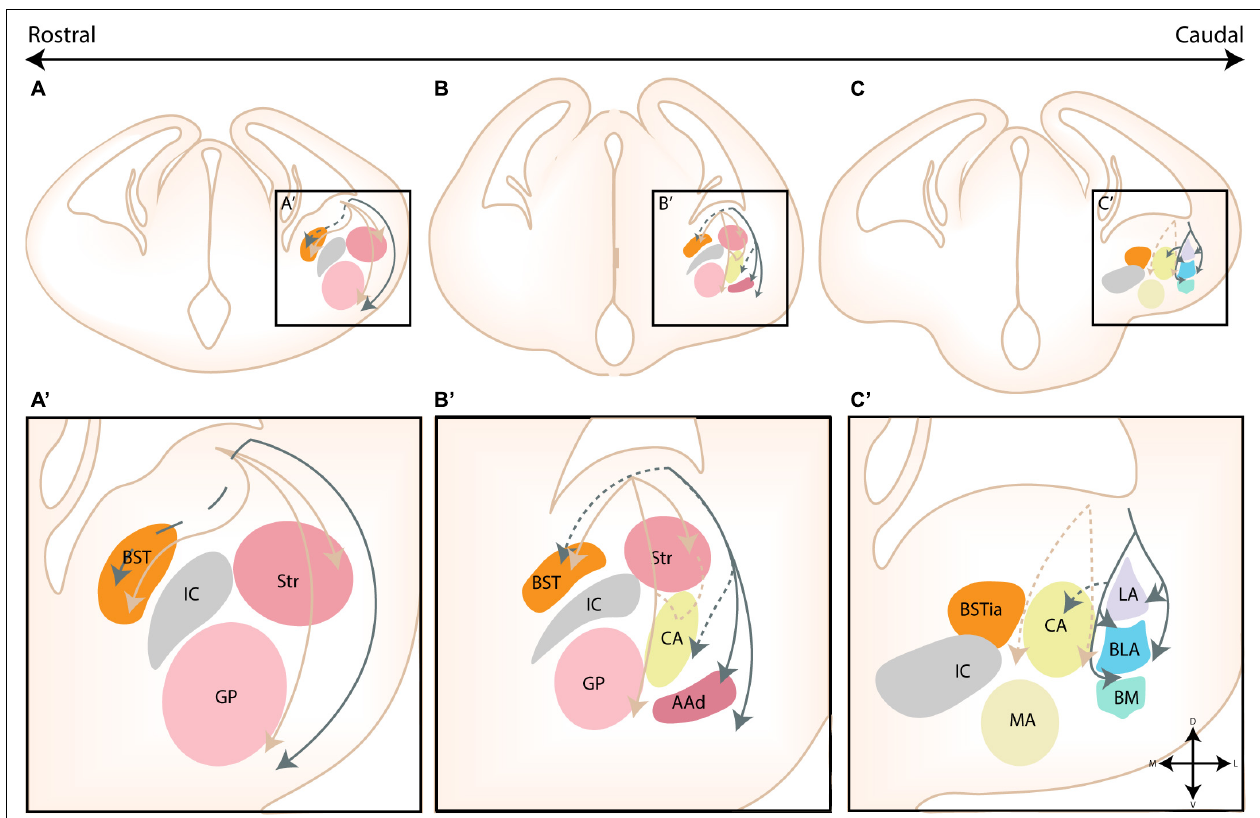
FIGURE 9 | Migratory routes of cells originating in the dorsal and ventral LGE. (A–C) Rostrocaudal gradient of schematic coronal sections showing the migratory routes of dorsal and ventral (dLGE/vLGE)-derived cells toward the striatum (Str) and amygdala. (A’–C’) zoom in of squares in panels (A–C) . (A,A’) At rostral levels, cells originating from the vLGE (brown arrows) migrate radially toward the striatum or tangentially, either toward the bed nucleus of the stria terminalis (BST) or via a route that passes the Str ventromedially. dLGE-derived neurons (gray arrows) instead migrate toward the olfactory cortices. A hypothesized tangential migration (striped line) delivers dLGE-derived cells to the BSTL. (B,B’) At intermediate levels, the three migratory routes of vLGE-derived interneurons can be visualized. The central amygdala (CA) receives cells from the vLGE, although it remains unclear whether this migratory stream is an extension of the radial migratory stream toward the Str or the stream that passes the Str ventromedially (possible migratory routes toward CA shown with striped lines). The hypothesized route of dLGE-derived cells toward the olfactory cortices and BST, respectively, can be visualized at intermediate levels. A subset of cells from the VMS also invade the AAd. The CA is also hypothesized to be invaded by dLGE-derived cells (striped line). (C,C’) At more caudal levels, two putative migratory streams from the vLGE, surrounding the CA, are shown with striped lines. These are hypothesized caudal extensions of the radial and tangential migratory routes of vLGE-derived neurons that might deliver cells toward the CA at more rostral levels. dLGE-derived cells migrate around the developing basolateral complex (BLC), thereby contributing to the intercalated cell masses that surround this complex. This medial stream around the BLC stream might additionally deliver cells to the CA (hypothesized, striped lines). AAd,